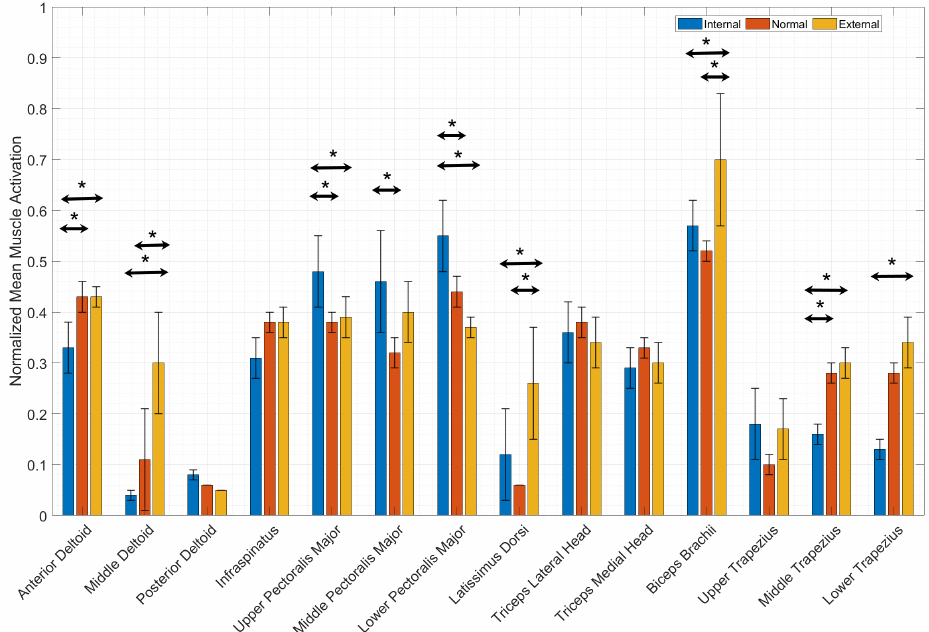
Figure 7. The mean and standard deviation of normalized muscle activities for 14 muscles: the anterior deltoid, middle deltoid, posterior deltoid, infraspinatus, upper pectoralis major, middle pectoralis major, lower pectoralis major, latissimus dorsi, triceps lateral, triceps medial, biceps brachii, upper trapezius, middle trapezius, and lower trapezius muscles in three rotational positions of palms (superior, normal, and inferior). The star sign indicates p -values < 0.05 with respect to Tukey–Kramer post-hoc significant difference